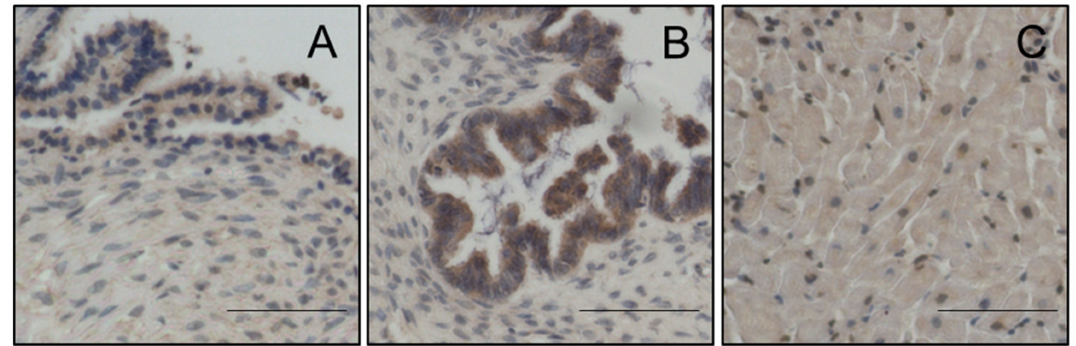
Figure 1. Magmas expression is higher in HGSOC than benign serous tumours. Representative immunohistochemistry images of Magmas in a ( A ) benign serous tumour and a ( B ) HGSOC. Benign (n = 8) and HGSOC (n = 17) were obtained from patients diagnosed with OC undertaking